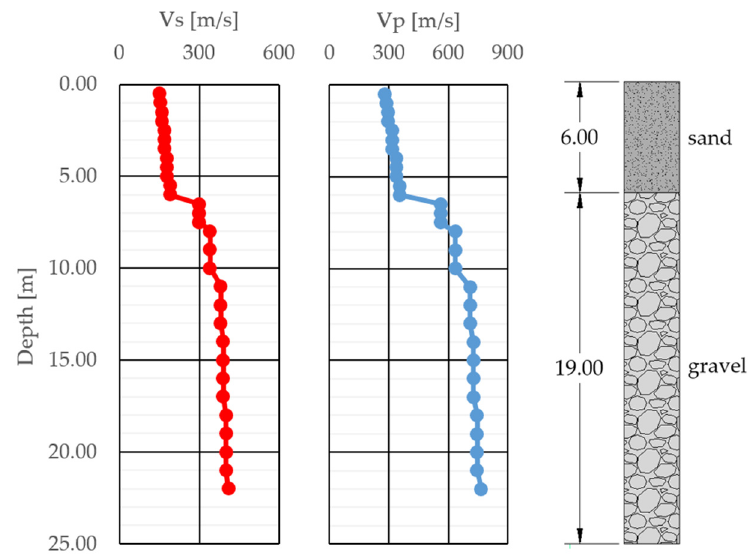
Figure 4. Soil profile. S-wave and P-wave velocities.